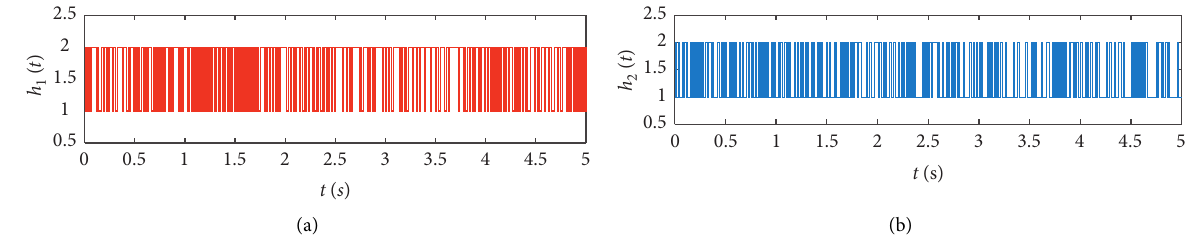
Figure 1: The jump mode H ( t ) of the PV-HMJSs. (a) The jump mode of the hidden state h